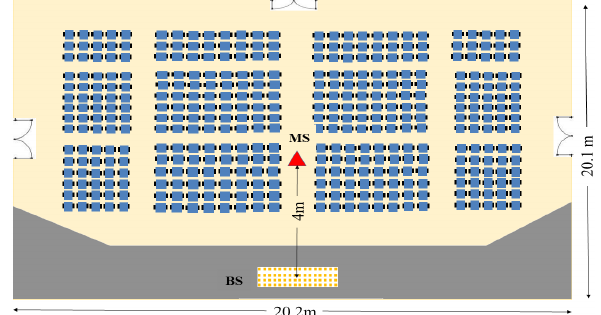
Figure 7. An overview of simulation